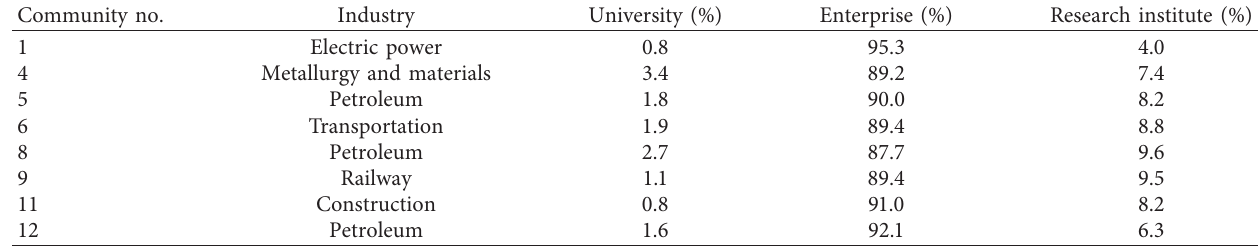
Table 7: Industry-university-research structure of the eight communities of innovation.